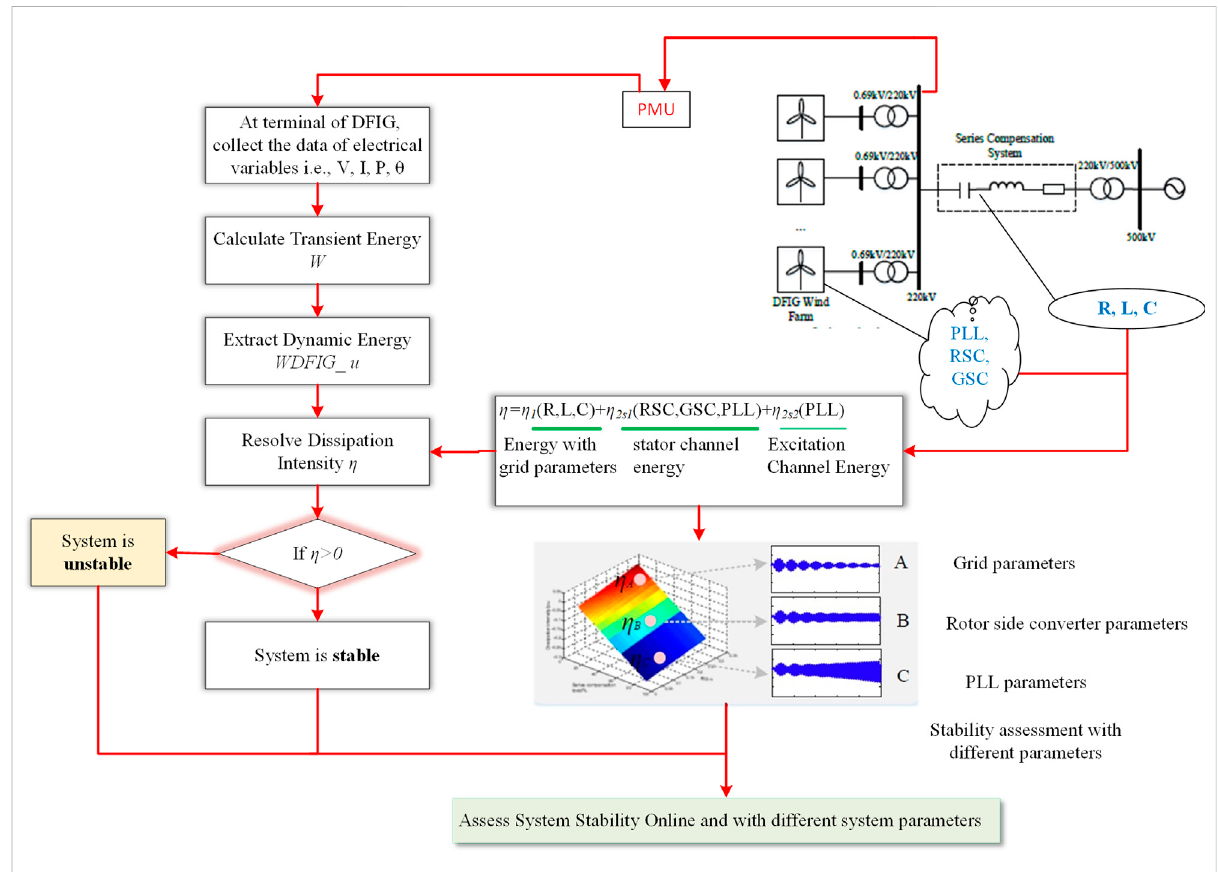
FIGURE 4 Logical representation of the assessment